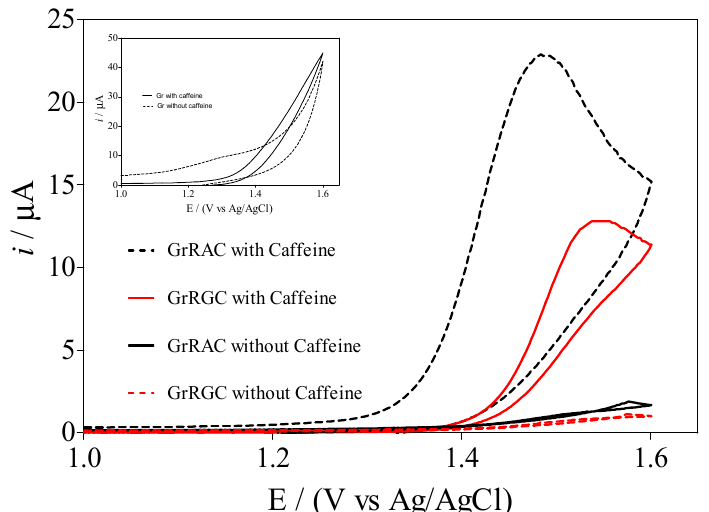
Figure 3. Cyclic voltammograms recorded at GrRAC and GrRGC electrodes in absence and presence of caffeine (0.01 M) in 0.5 M H 2 SO 4 at 100 mV s − 1 . Inset: Gr electrode, in absence and presence of caffeine (0.01 M).